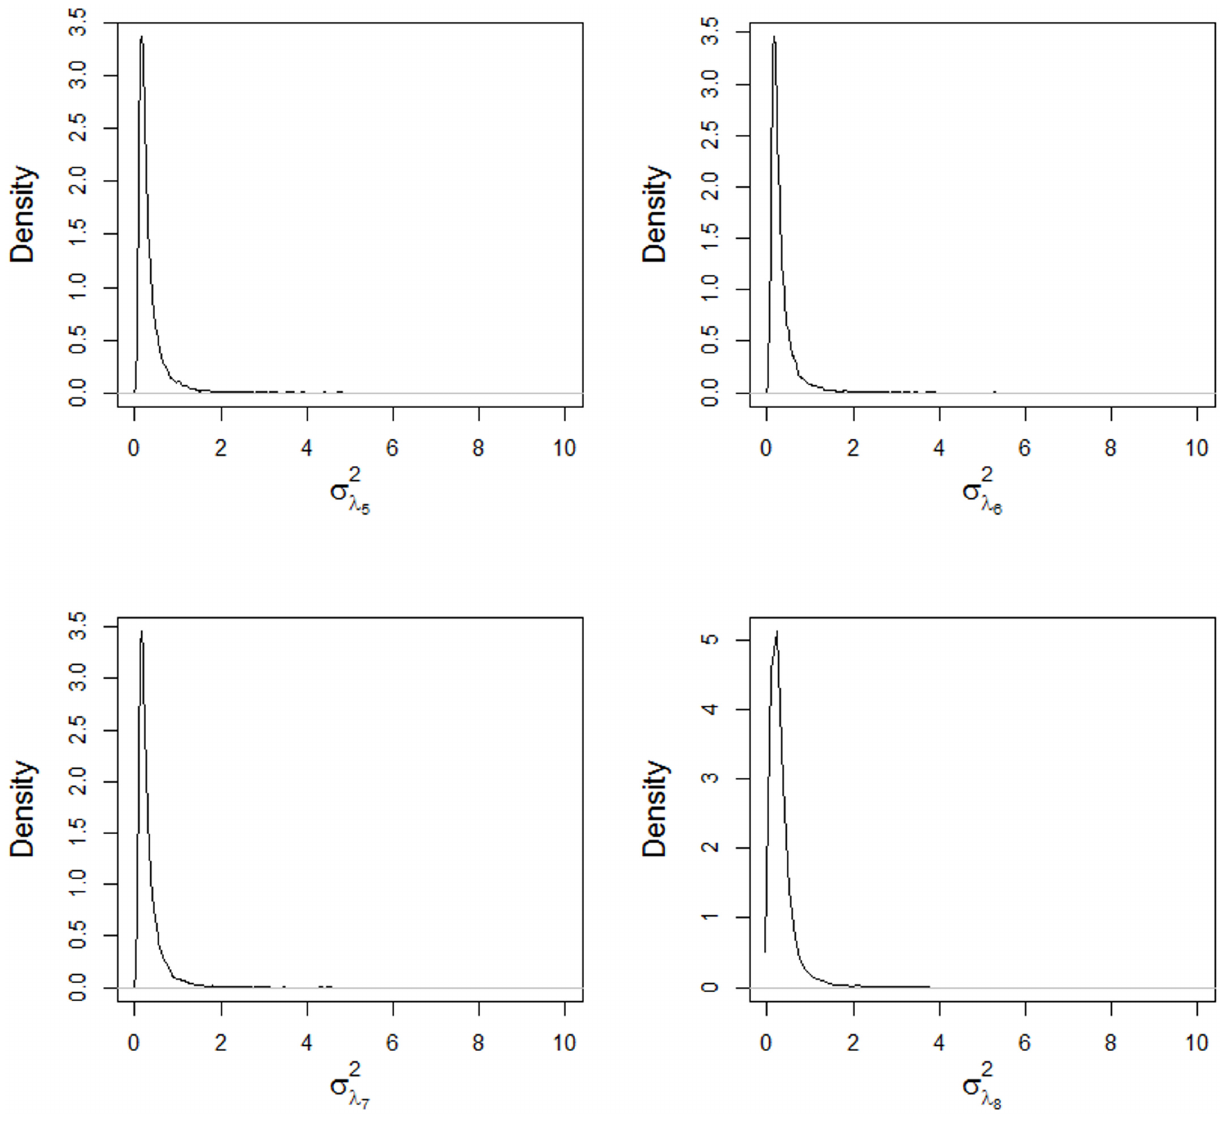
; σ 2 ; σ 2 σ 2 λ 6 λ 7 and λ 8 , obtained using the AMMIBS model. 5